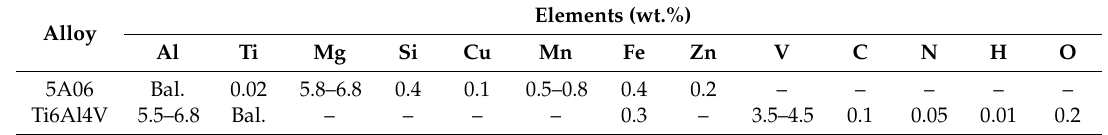
Table 1. Chemical composition of the 5A06 and Ti6Al4V alloys.